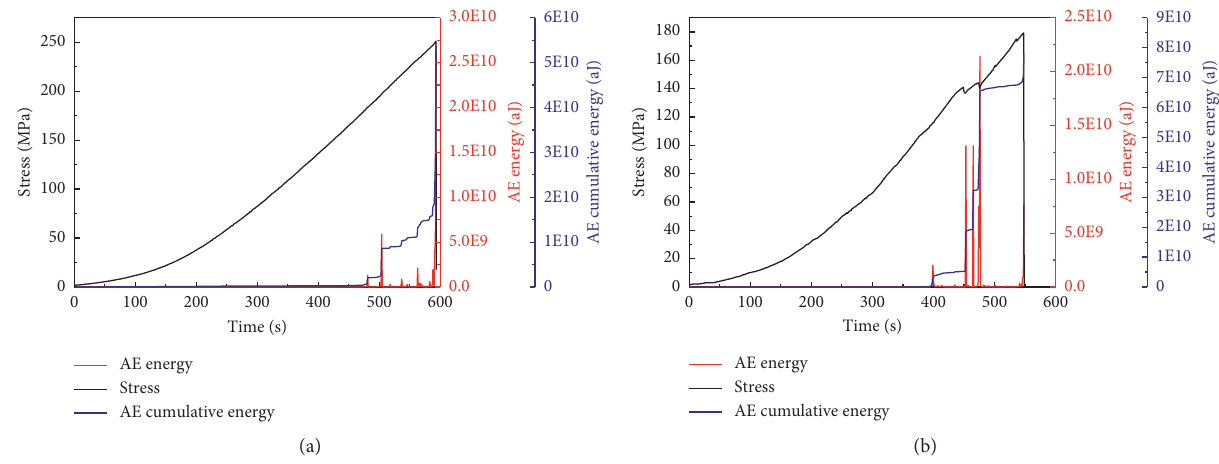
Figure 8: AE energy and cumulative energy evolution of the intact specimen (a) and the intact specimen containing an opening